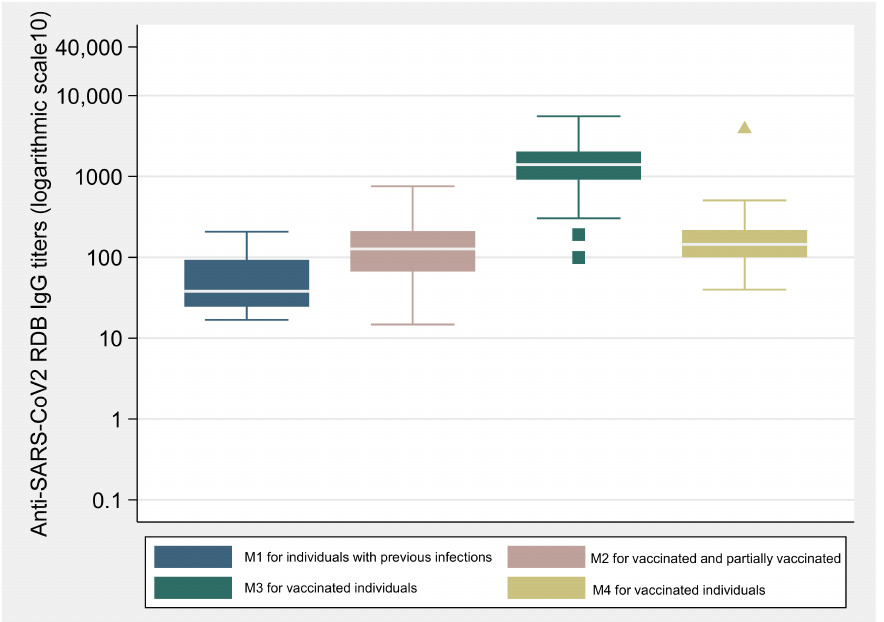
Figure 1. Concentration of IgG anti-SARS-CoV-2 spike receptor-binding domain (RBD) titers (log- arithmic scale 10) reported in the box-whisker plots (and outliers) for individuals with previous infection at M1 and vaccinated individuals without previous infection for the three different moments of observation.